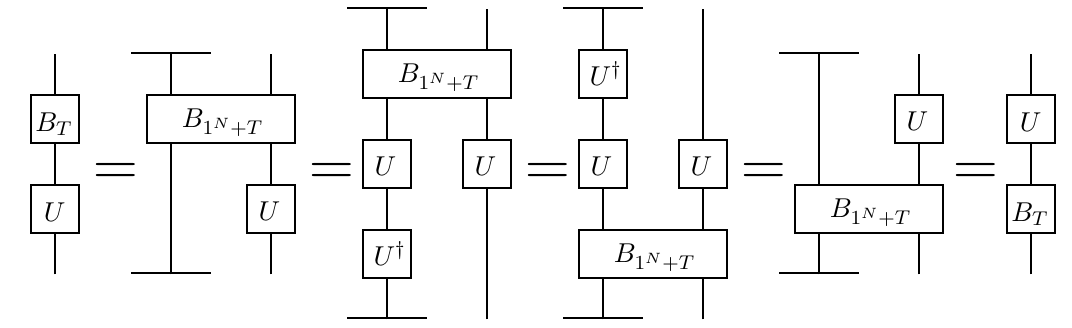
Figure 10 . B T is a partial trace of B indices, which are split into a set of N and a set of 2 q . The two lines represent these two sets respectively. The horizontal lines then indicate we trace over the (cid:12)rst N indices, while the open line indicates the remaining 2 q indices are left free.